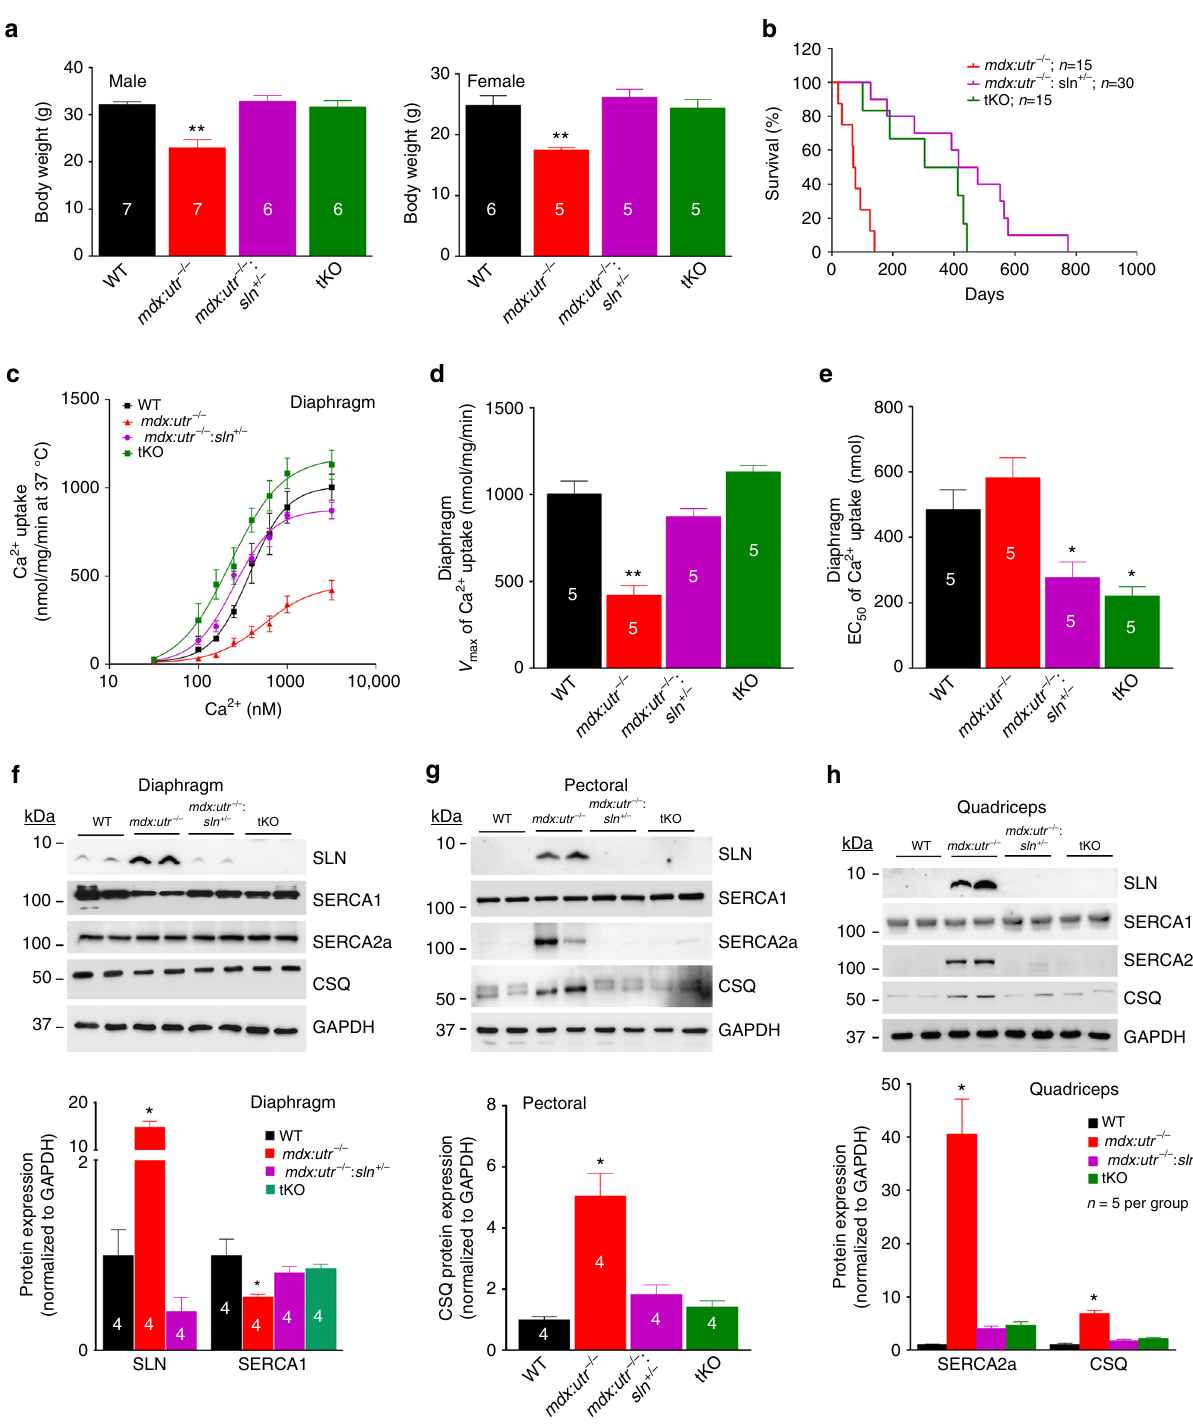
Fig. 1 Reduction in SLN expression prolongs the lifespan of mdx:utr − / − mice. a The body weight of mdx:utr − / − :sln + / − and tKO mice in comparison to that of age- and sex- matched WT and mdx:utr − / − control mice. We used 3 – 4 month old mice for this experiment. The n number for each group is shown within the bar. Data are presented as mean ± SEM. **signi fi cantly different from other groups ( p < 0.005, t -test with Welch ’ s correction). b Kaplan – Meier survival curves indicate that the mdx:utr − / − :sln + / − and tKO mice has increased lifespan in comparison to that of mdx:utr − / − controls as determined by the nonparametric log-rank test; p < 0.0001. c Increased Ca 2+ dependent SR Ca 2+ uptake, d increased V max of Ca 2+ uptake and e decreased EC 50 values in the diaphragm of mdx:utr − / − :sln + / − and tKO mice indicates improved SERCA function. The n number for each group is shown within the bar. Data are presented as mean ± SEM. **signi fi cantly different from other groups ( p < 0.0005, t -test with Welch ’ s correction). *signi fi cantly different from WT and mdx:utr − / − mice ( p < 0.005, t -test with Welch ’ s correction). f – h Representative western blot analysis and quantitation of SLN, SERCA1, SERCA2a and CSQ proteins in the diaphragm, pectoral and quadriceps muscles respectively. Tissues are from 3 to 4 month old mice. Uncropped scans of western blots are shown in Supplementary Fig. 8a – c. Data are represented as mean ± SEM. The n number for each group is shown within the bar diagram. *signi fi cantly different from other groups, p < 0.05, t -test with Welch ’ s correction NATURE COMMUNICATIONS | 8: 1068 | DOI: 10.1038/s41467-017-01146-7 |